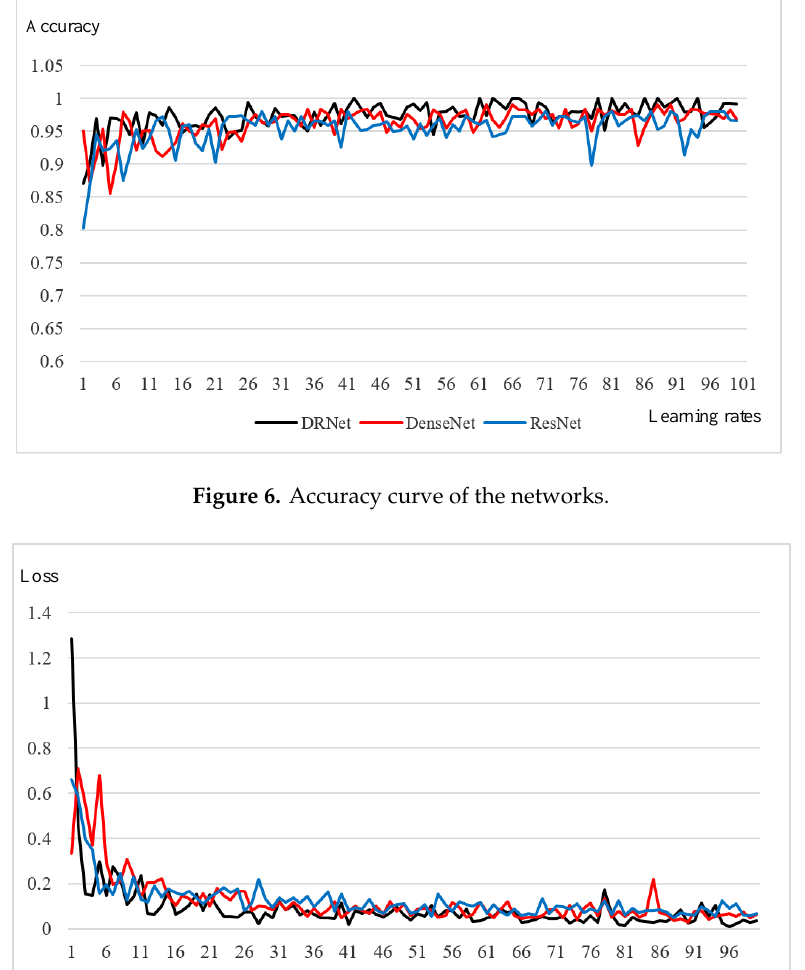
Figure 8. Precision–recall (PR) curve for Potala Palace in Lhasa.